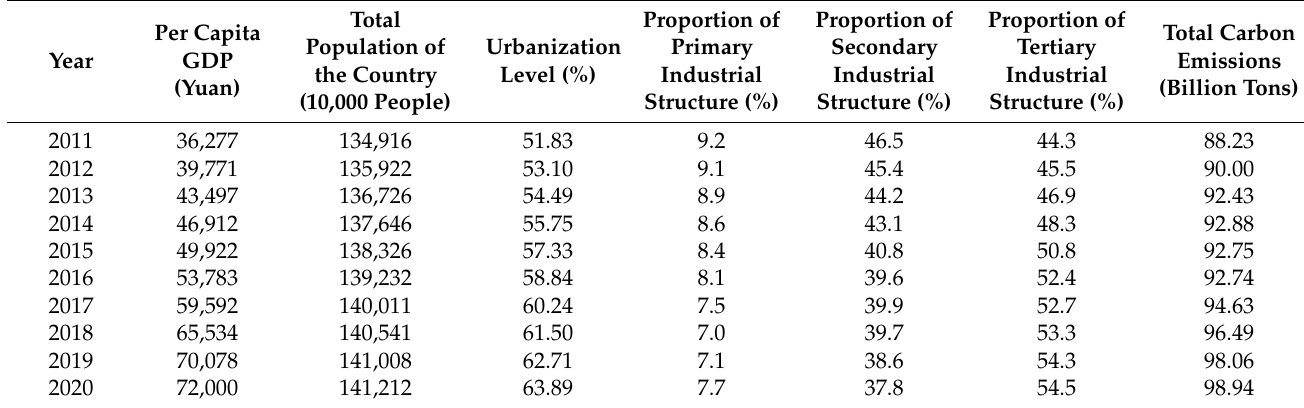
Table 2. China’s economic and social data from 2011 to